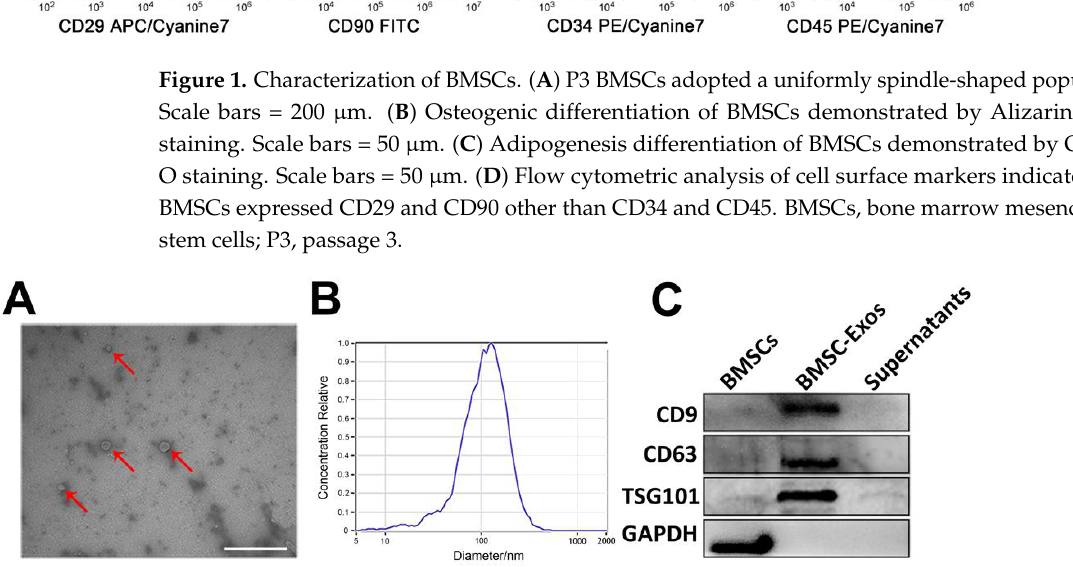
Figure 2. Identification of BMSC-Exos. ( A ) Cup-shaped morphology of purified BMSC-Exos (indi- cated with arrows) observed by TEM. Scale bar = 500 nm. ( B ) Particle size distribution and concen- tration of BMSC-Exos analyzed by NTA. ( C ) Western blots of exosomal membrane markers CD9, CD63, and TSG101. BMSC-Exos, bone marrow mesenchymal stem cell-derived exosome; TEM, transmission electron microscope; NTA, nanoparticle tracking analysis.